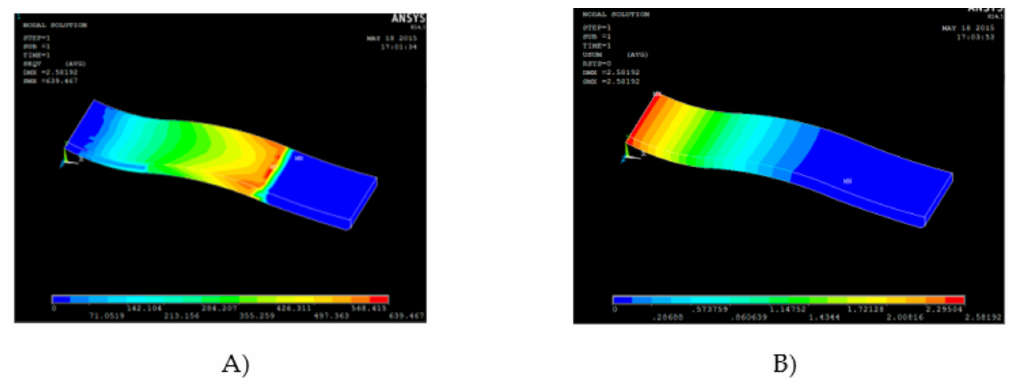
Figure 20. Case 2: Numerical analysis for MH. ( A ) Stress. ( B ) Deformation.